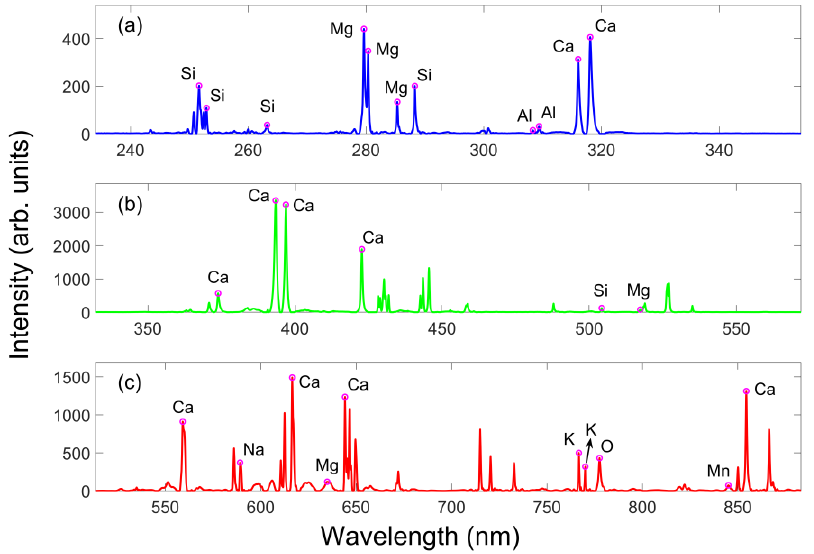
Figure 8. The LIBS spectrum collected from the wollastonite reference sample, in the ordinary laboratory environment. ( a ) The spectrum in Channel 1 (blue line). ( b ) The spectrum in Channel 2 (green line). ( c ) The spectrum in Channel 3 (red line). The identified characteristic peaks of several elements are marked out (magenta circles).